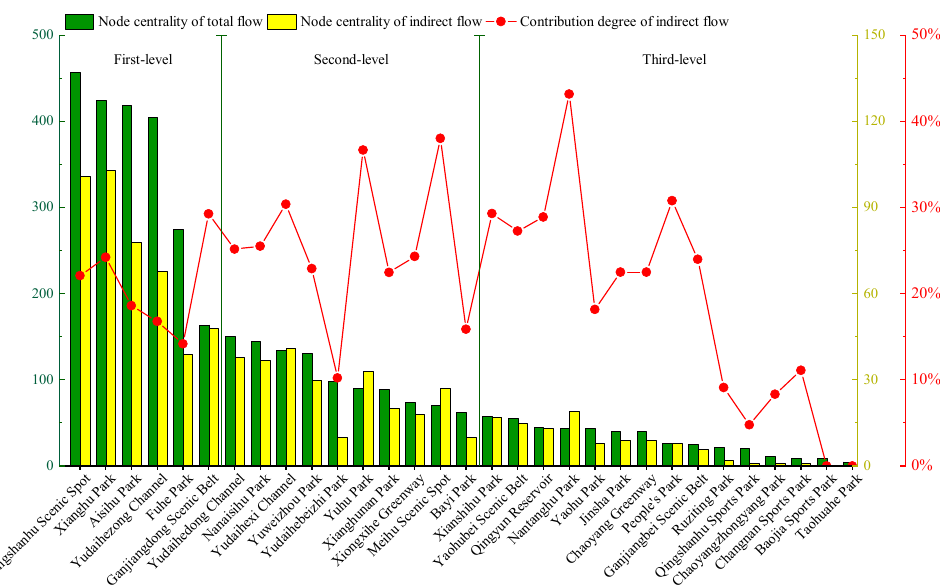
Figure 3. Centrality of each node in the total and indirect flows.